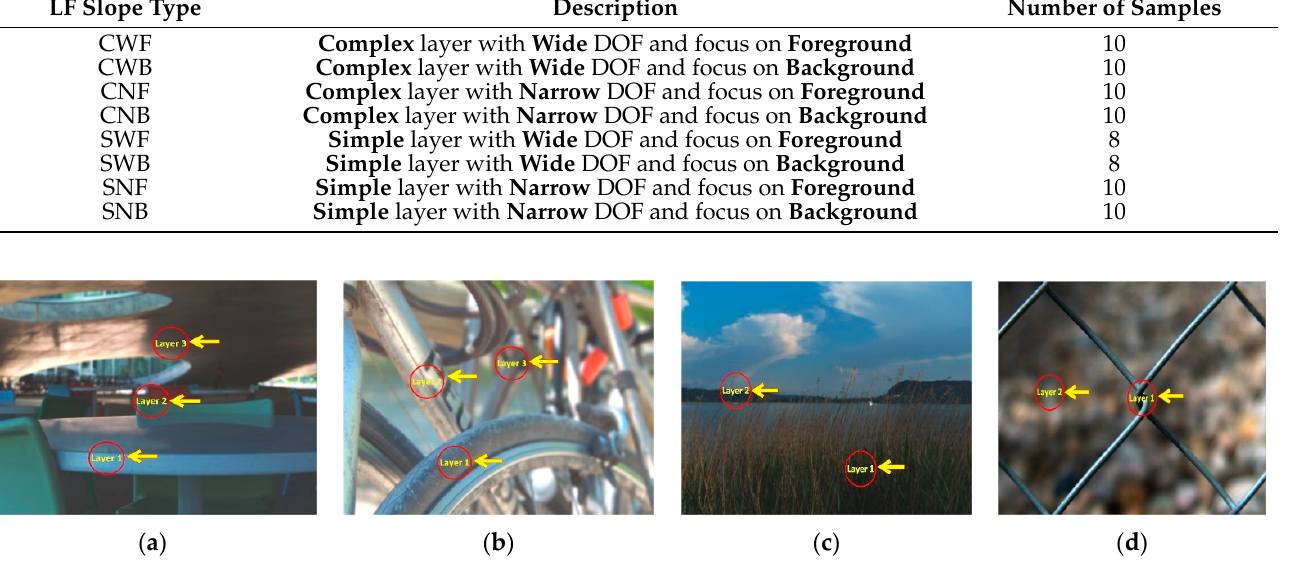
Figure 4. Thumbnails of the LF dataset with different conditions: ( a ) Complex layer with wide DOF, ( b ) Complex layer with narrow DOF, ( c ) Simple layer with wide DOF and ( d ) Simple layer with narrow DOF.